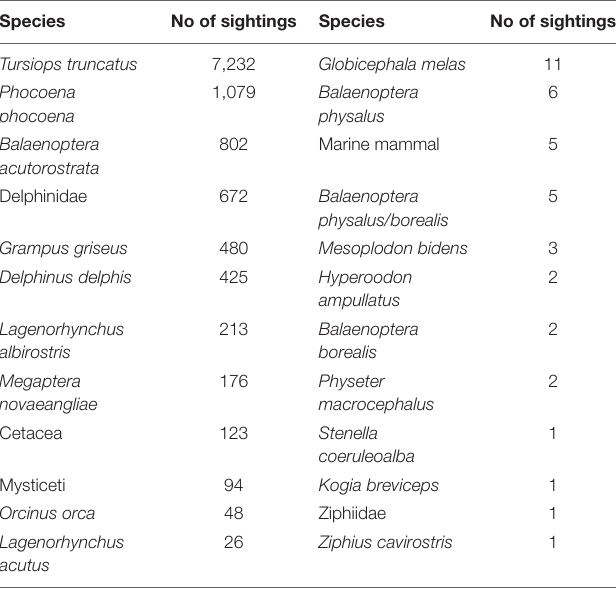
TABLE 4 | Number of sightings per species.